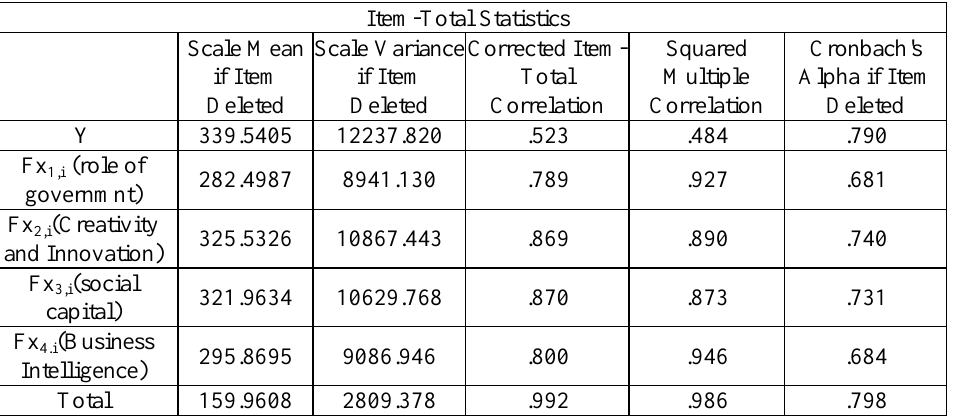
Table. 6: Descriptive Statistics of Cronbach's alpha Calculations for Validity and Reliability of the